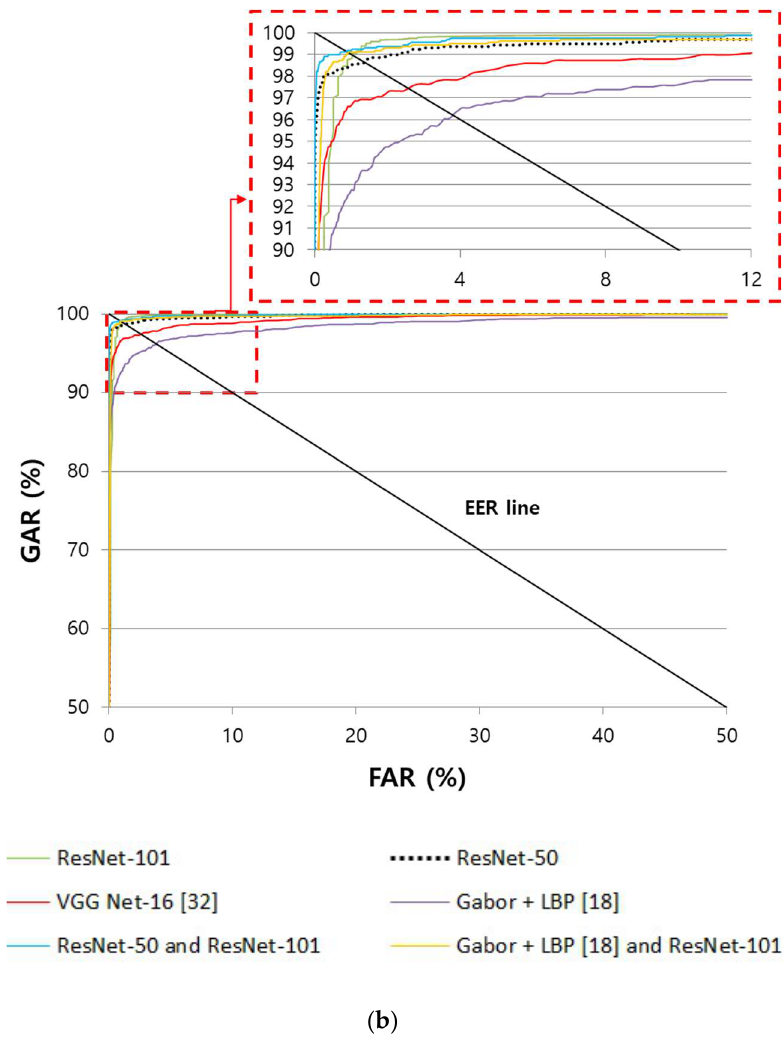
Figure 9. Comparison of receiver operating characteristic (ROC) curves of finger-vein recognition with ( a ) SDU-DB and ( b ) PolyU-DB.